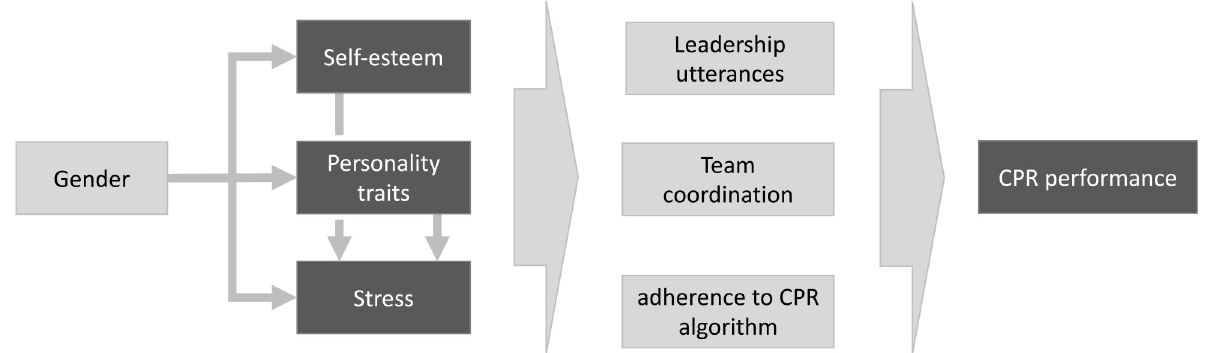
Fig 1. Hypothesized relationships between gender, psychological variables and CPR